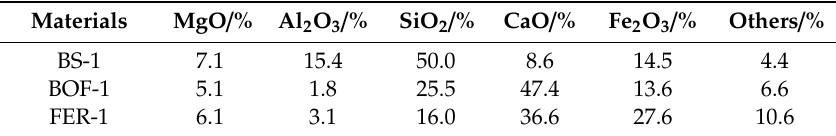
Table 2. Chemical compositions of three kinds of aggregates.